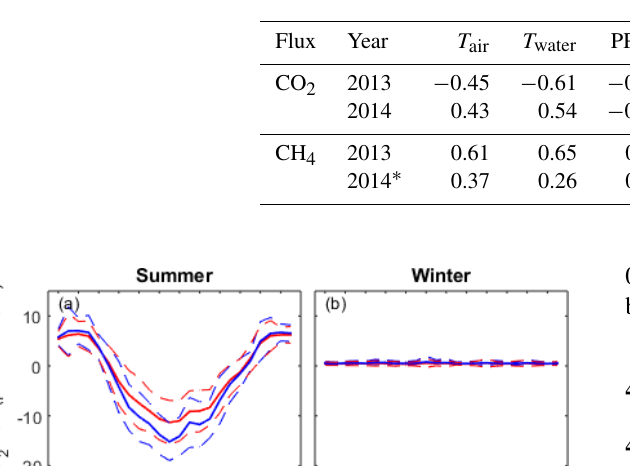
Figure 5. Monthly average of (a) diffusive CO 2 and (b) CH 4 flux from the open water in 2013. Error bar indicates the standard error of the mean. From January to March there was an ice-covered period. Table 1. Pearson correlation coefficient ( r ) between the daily averages of environmental variables and fluxes in 2013 and 2014. NEE – net ecosystem exchange; T air – air temperature; T water – water temperature; PPFD – photosynthetic photon flux density; WL – water level; [CO 2 ] and [CH 4 ] – CO 2 and CH 4 concentration measured in the outlet; ∗ indicates only peak growing seasons (June, July and August) are included in the analysis.